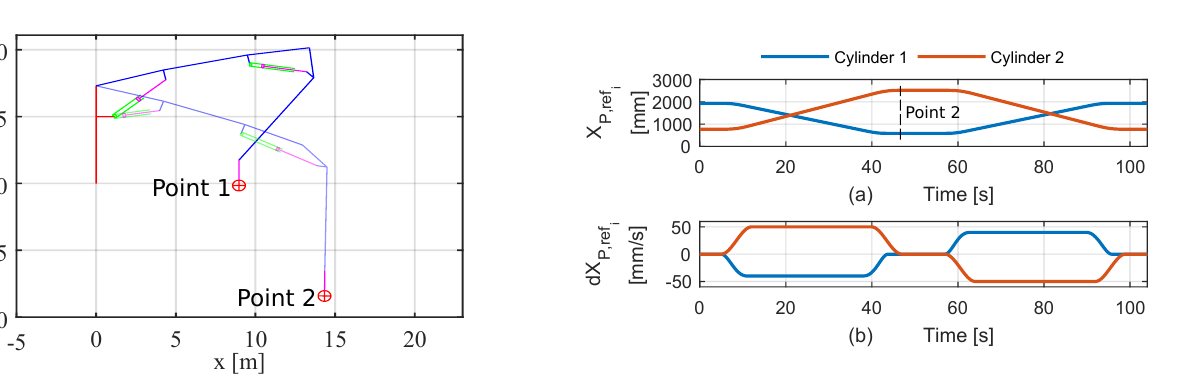
Figure 12: Test case trajectory in actuator space. The start and end point correspond to point 1 in Fig. 11. Point 2 is marked.